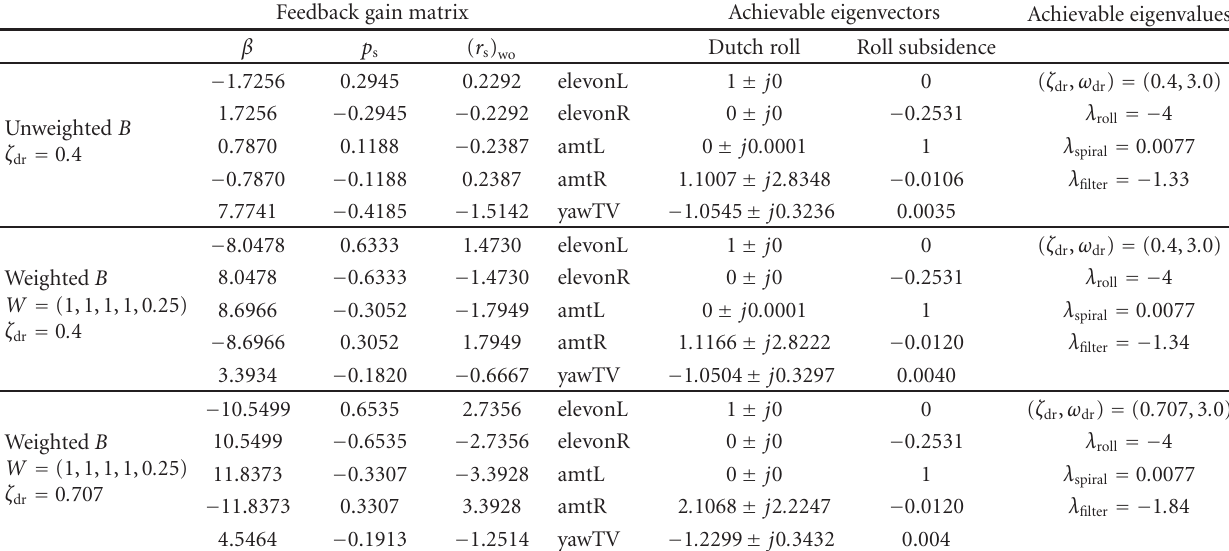
Table 3: Lateral eigenstructure assignment design a .